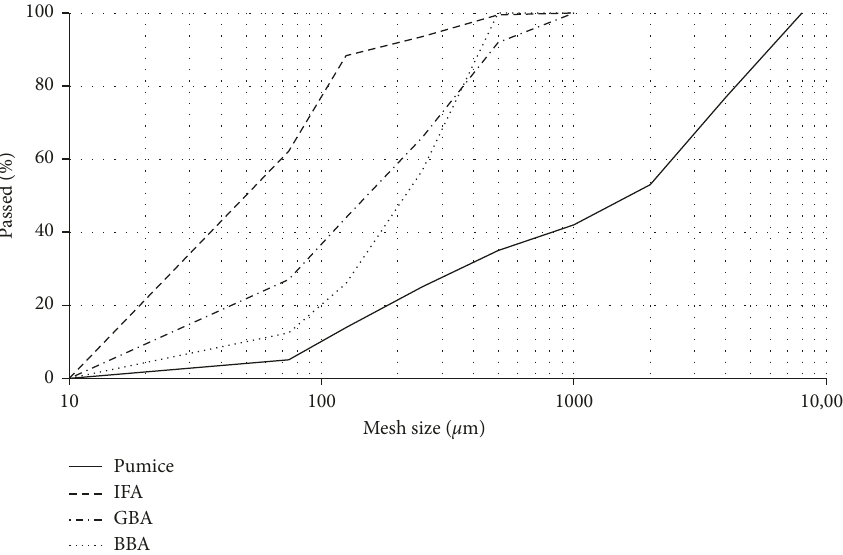
Figure 1: Granulometric distribution of pumice, IFA, GBA, and BBA.